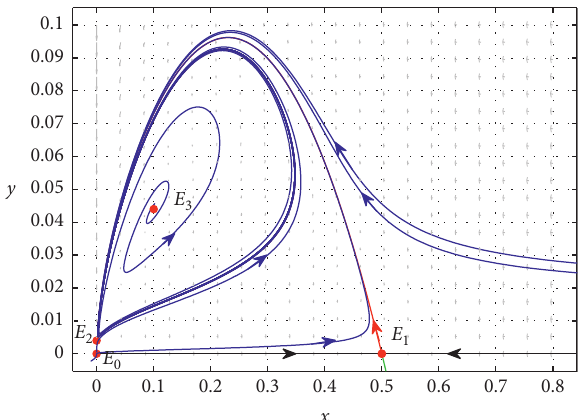
Figure 4: Phase portrait for system (12) with α � ρ � 1 , β � 0 . 5, m � 0 . 01, c � 0 . 5, and δ � 0 . 8.